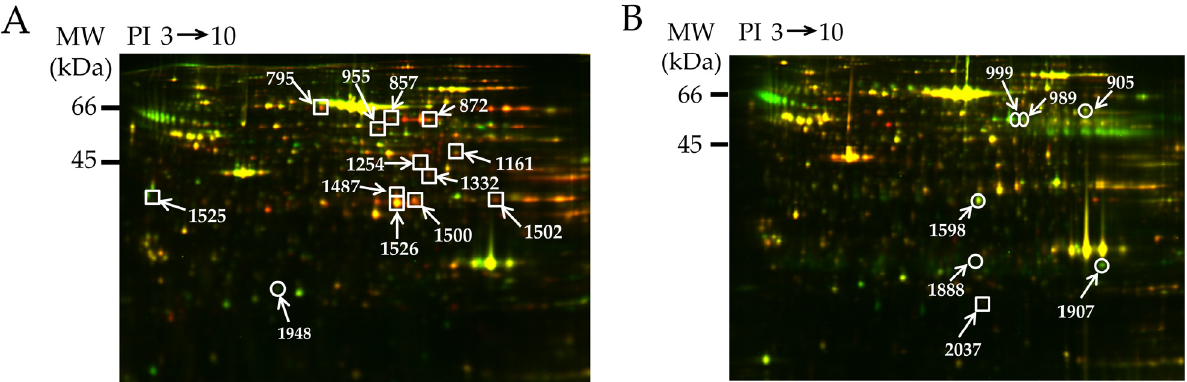
Figure 2. 2D-DIGE gel images. Representative 2D-DIGE images of proteins in epididymal adipose tissues of ( A ) 6- and ( B ) 25-week-old WKY and CP. The proteins (25 µ g) were labeled with Cy3 and Cy5 dyes, mixed, and subjected to 2D-DIGE analysis. We selected significantly different spots of 6- and 25-week-old CP compared with age-matched rats (WKY and Lean). Squares: up-regulated spots, circles: down-regulated spots.